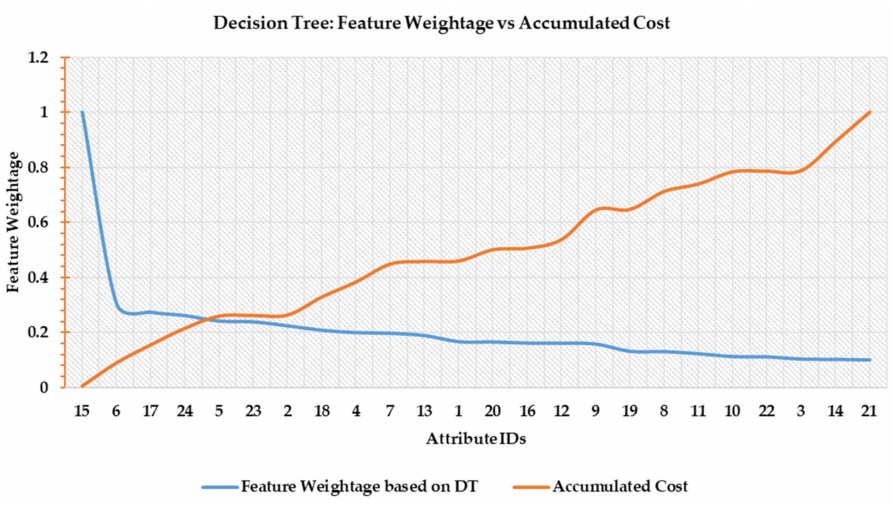
Figure 6. Decision tree-based feature scoring.